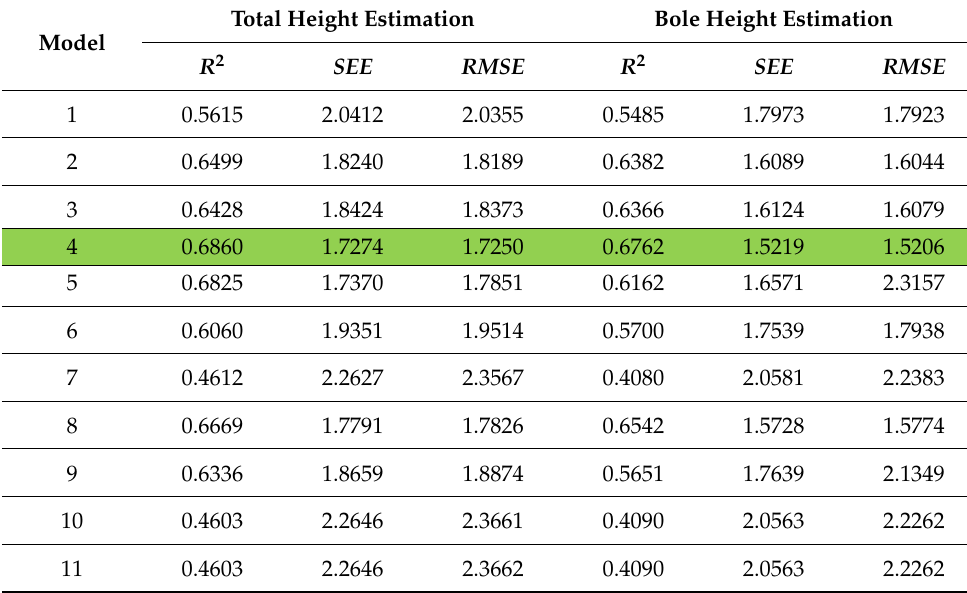
Table 5. Values for the comparison criteria for selecting the best height–diameter model.